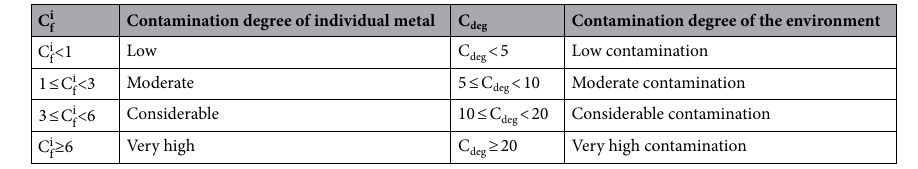
i f ) 53 , Degree of contamination (C deg ) 57